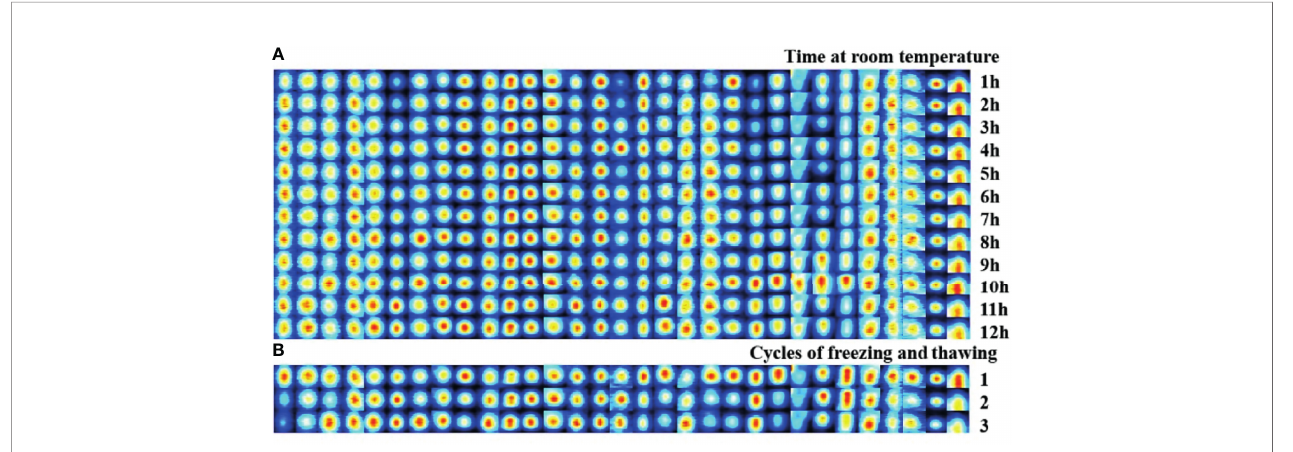
FIGURE 1 | Stability evaluation of bile VOCs analysis with GC-IMS. (A) Room-temperature stability was assessed in the same samples that measured in parallel every hour within 12 hours, with a total of 12 injections. (B) Freeze/thaw sta-bility evaluation was assessed in the same samples that measured within three freeze- thaw